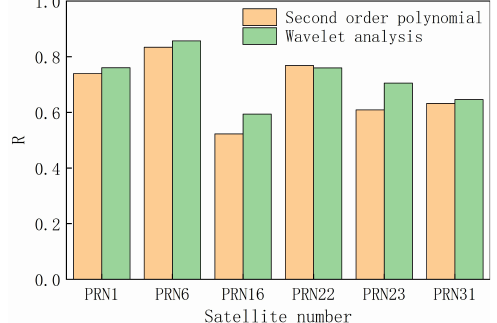
Fig.4 R between scheme 1 and scheme 2